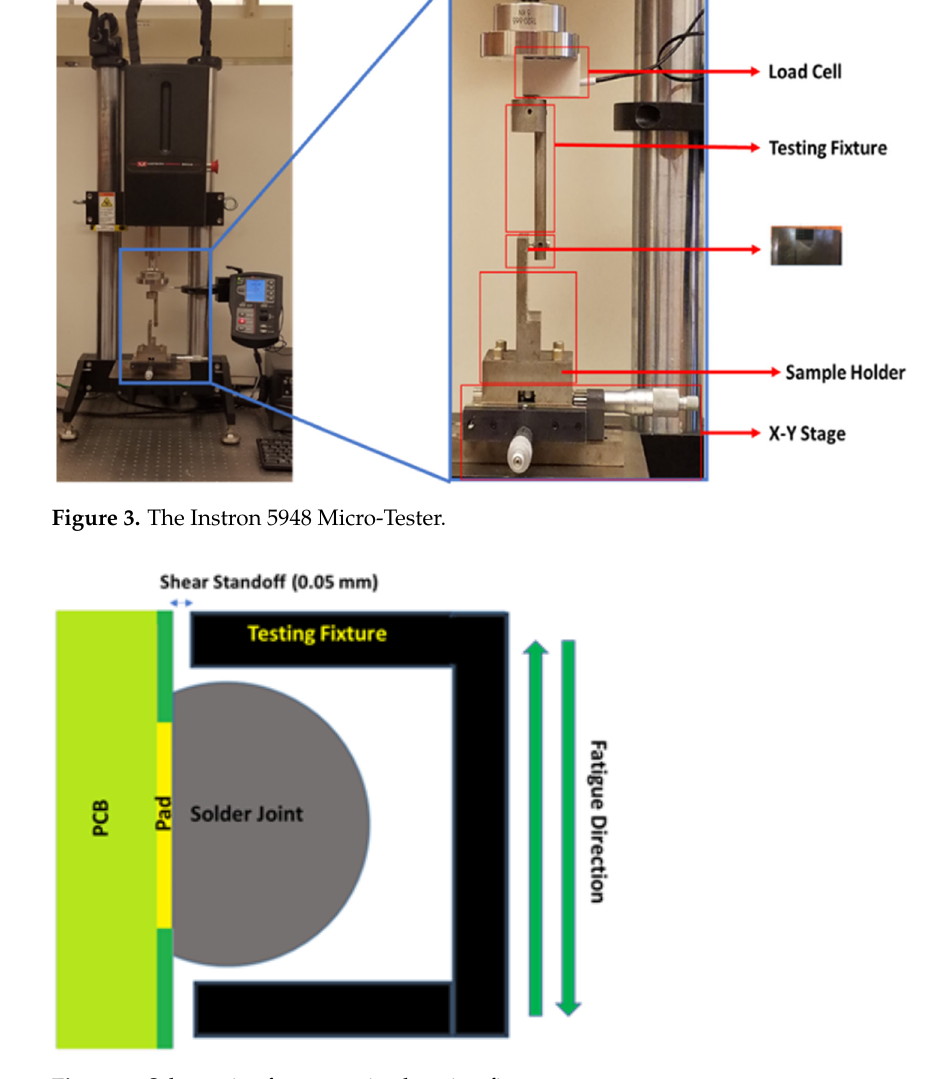
Figure 4. Schematic of a customized testing fixture.